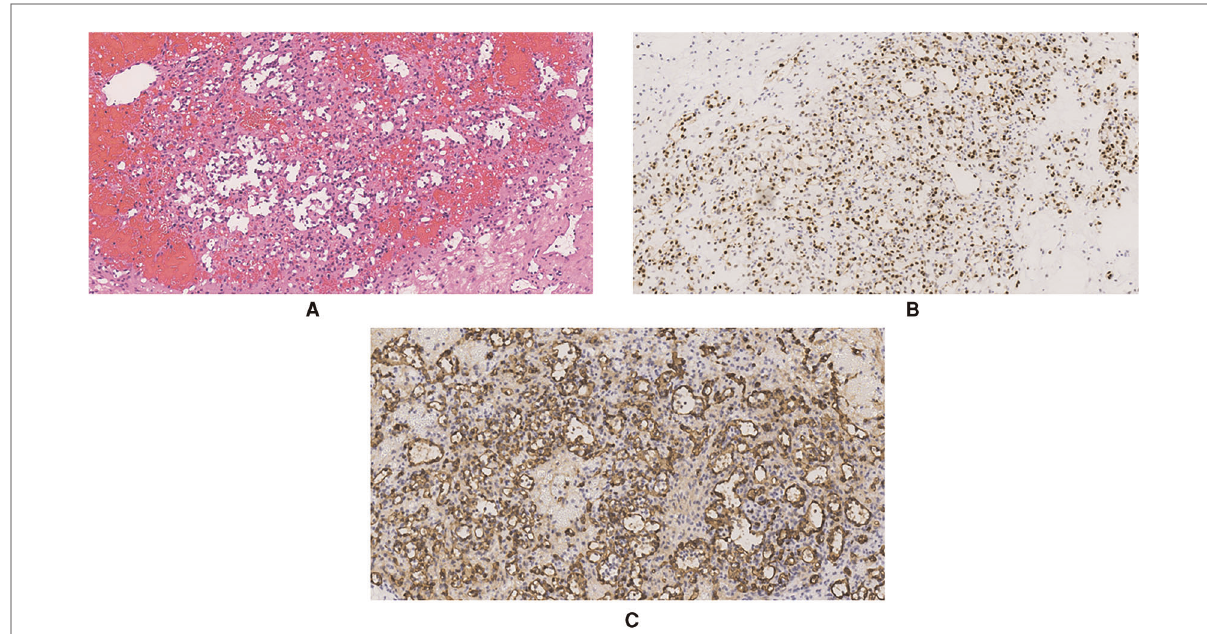
FIGURE 4 Pathological examination showing that the mass was composed of distinctive “ anastomosing ” capillary-sized vessels lined by “ hobnail ” endothelial cells. ( A ) Hematoxylin and eosin (HE) staining (×200). ( B ) Immunohistochemistry staining of ERG in endothelial cells (×200). ( C ) Immunohistochemistry staining of CD34 in endothelial cells